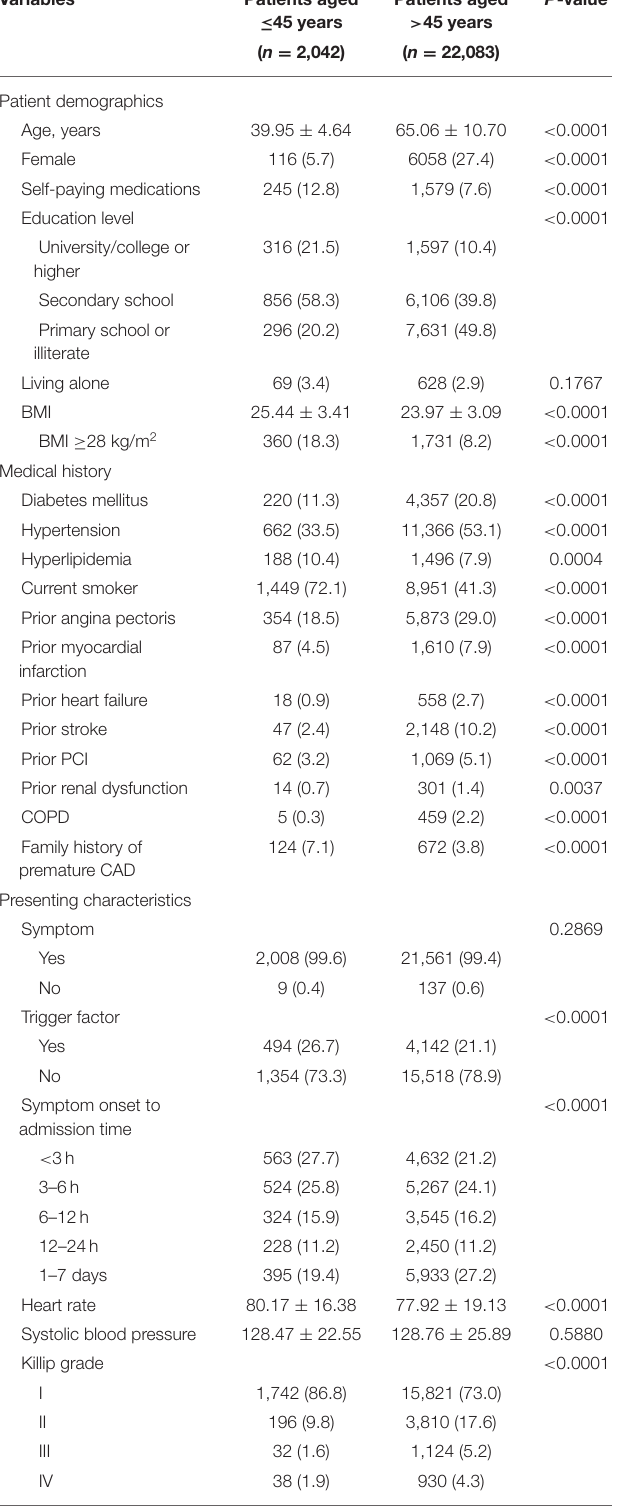
TABLE 1 | Baseline characteristics of patients in different age groups.